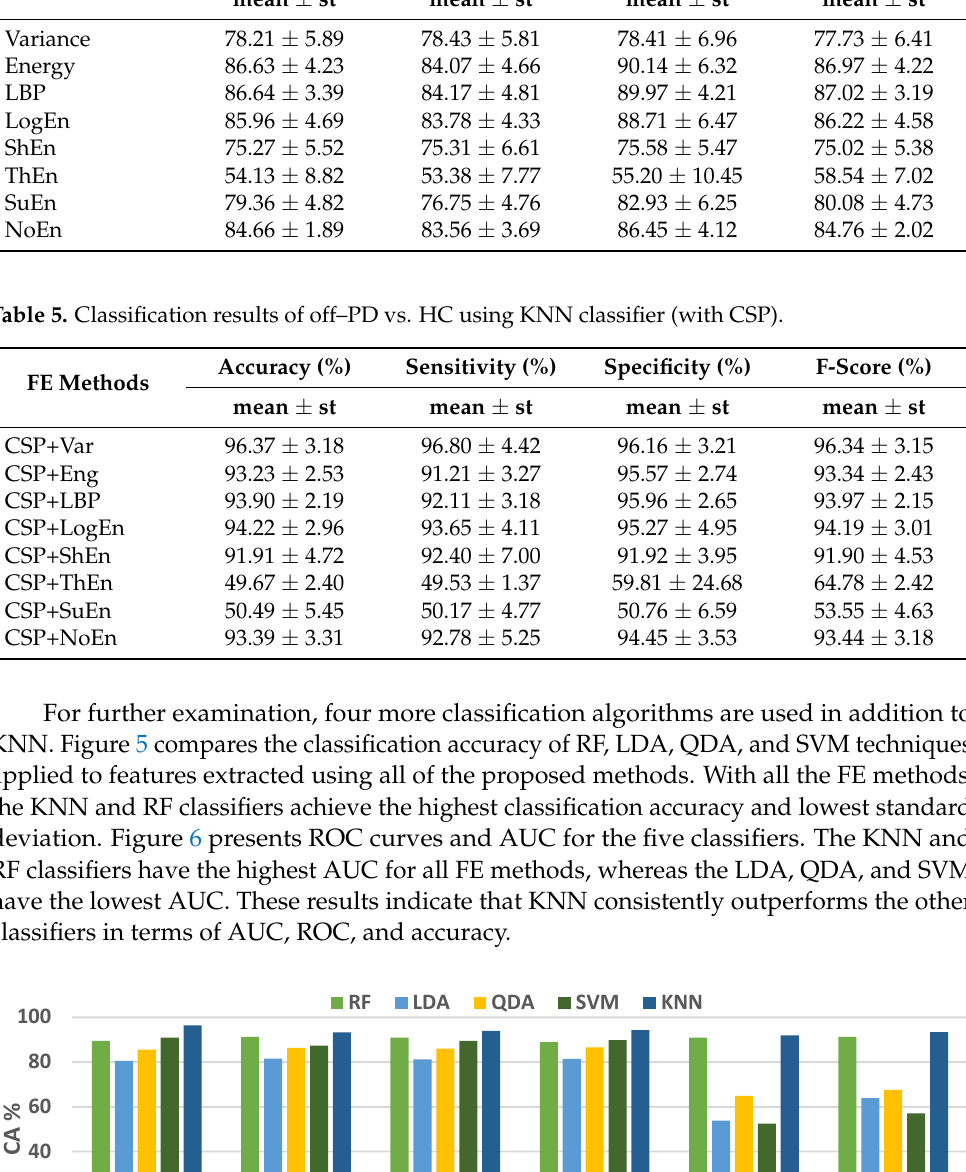
Figure 6. ROC and AUC of off–PD vs. HC classification based on features extracted from ( a ) CSP+Var, ( b ) CSP+Eng, ( c ) CSP+BP, ( d ) CSP+LogEn, ( e ) CSP+ShEn and ( f ) CSP+NoEn. Investigation of Frequency Bands EEG signals have a frequency range of 0 to 100 Hz, which is typically decomposed into five sub-bands: delta (<4 Hz), theta (4–8 Hz), alpha (8–13 Hz), beta (13–30 Hz), and gamma (>30 Hz). In this subsection, the aim is to find the sub-bands that lead to the high- est PD classification performance. The gamma range has been eliminated from this study due to artifacts that may adversely affect the classification accuracy. Figure 7 depicts the classification accuracy when applying all of the proposed methods to different EEG sub- bands. According to the results shown in the figure (dark blue and yellow), in the highest